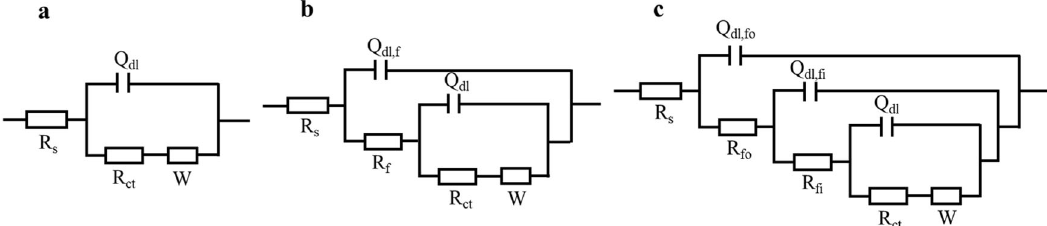
Fig. 9 Equivalent circuits. R s is the solution resistance, Q dl,f is the bilayer capacitance of the deposited layer, R f is the charge transfer resistance of the deposited layer, Q dl is the bilayer capacitance of corrosion at the deposited layer/base metal interface, R ct is the charge transfer resistance, and W is the cathode fi nite length Warburg